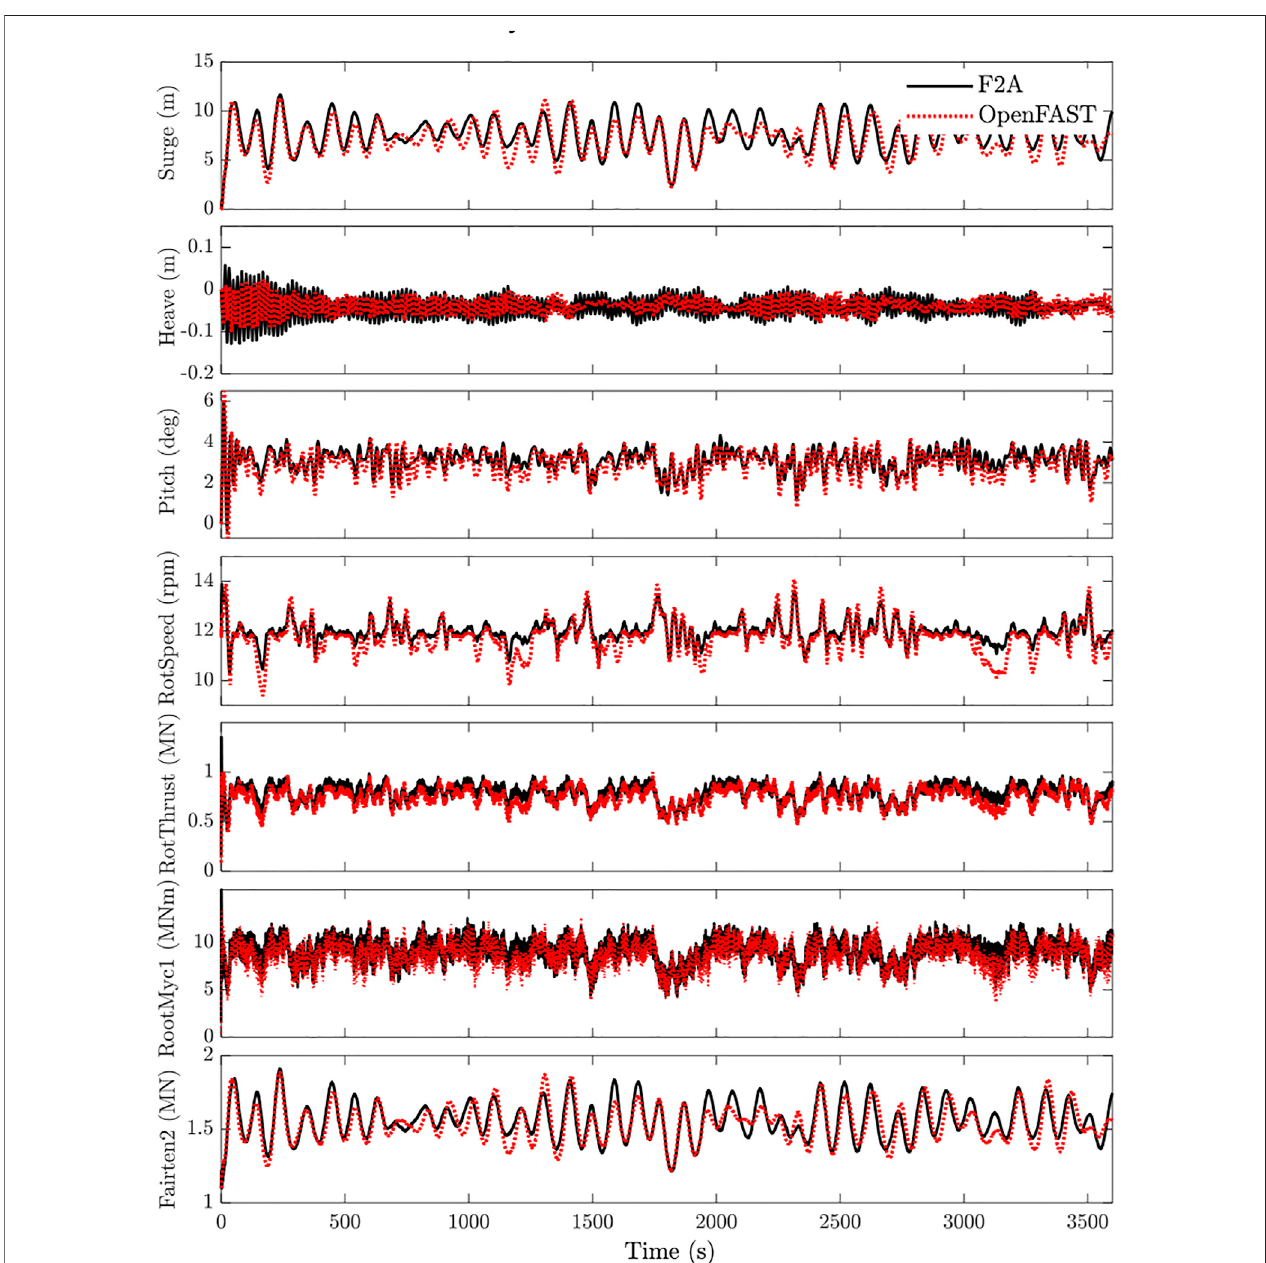
FIGURE 4 | Comparison of dynamic responses between F2A and